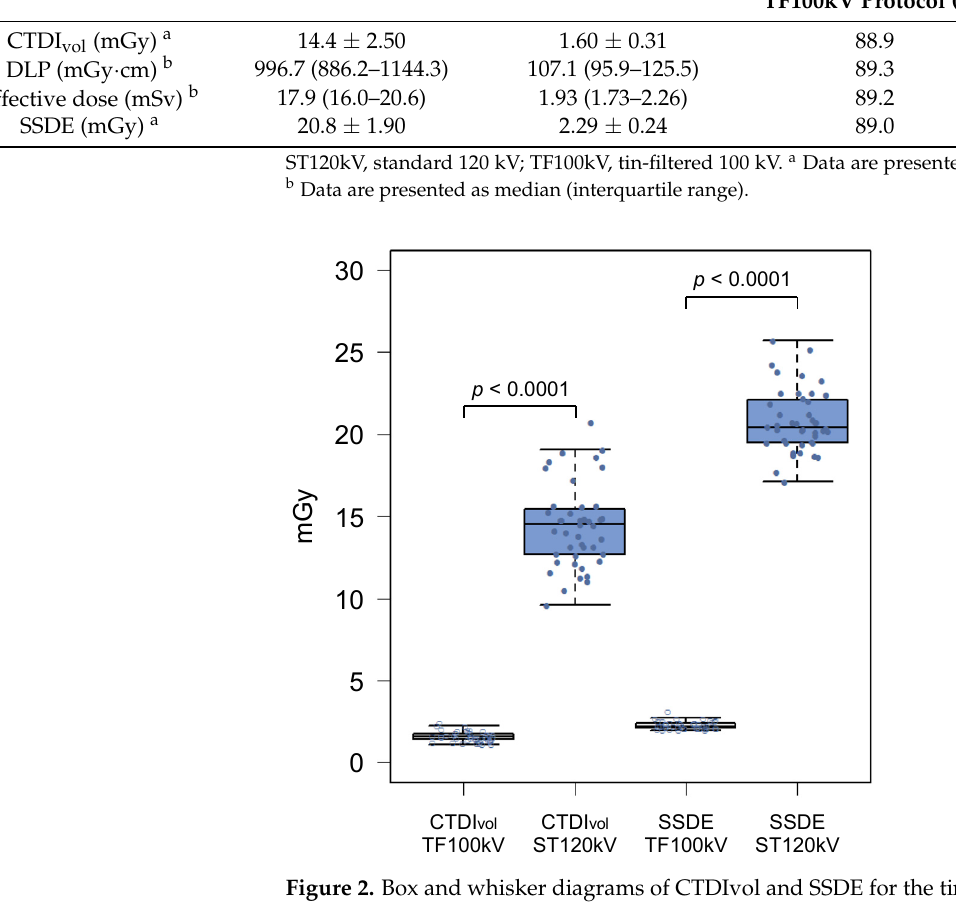
Figure 2. Box and whisker diagrams of CTDIvol and SSDE for the tin-filtered 100 kV (TF100kV) and standard 120 kV (ST120kV) protocols.